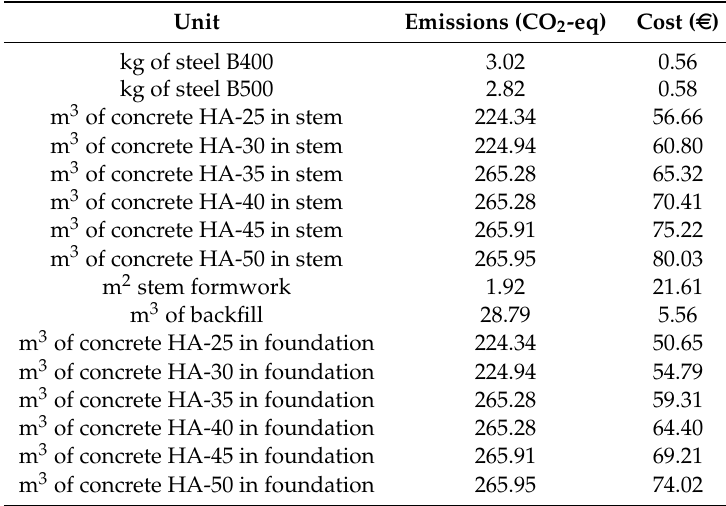
Table 1. Unit breakdown of emissions and